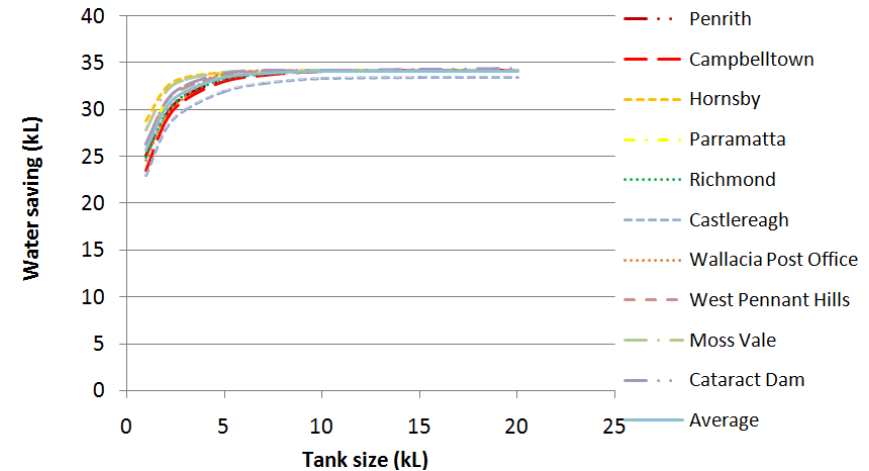
Figure 6. Water savings from a RWHS for toilet and laundry use (considering the daily rainfall data of all the years on record).